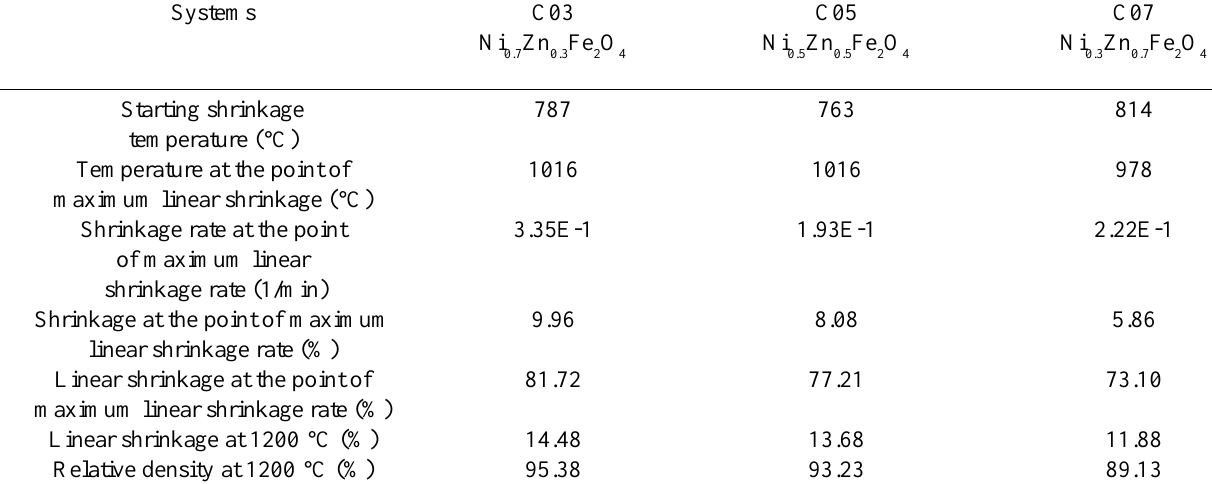
Table 2. Results of sintering at 1200 °C for the C03, C05 and C07 systems with a constant heating rate of 5 °C/min.